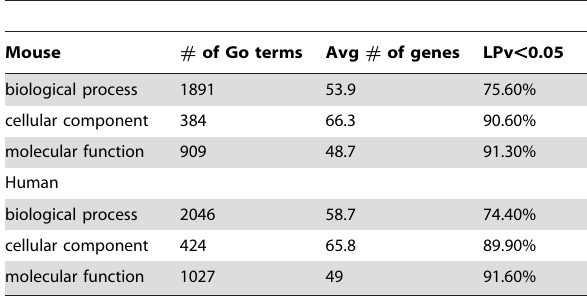
Table 2. Performance of LPv methodology on gene sets in GO categories.